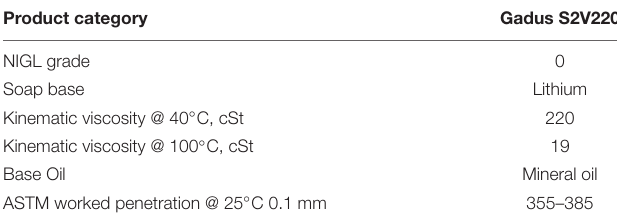
TABLE 1 | Features of the grease used in this paper.